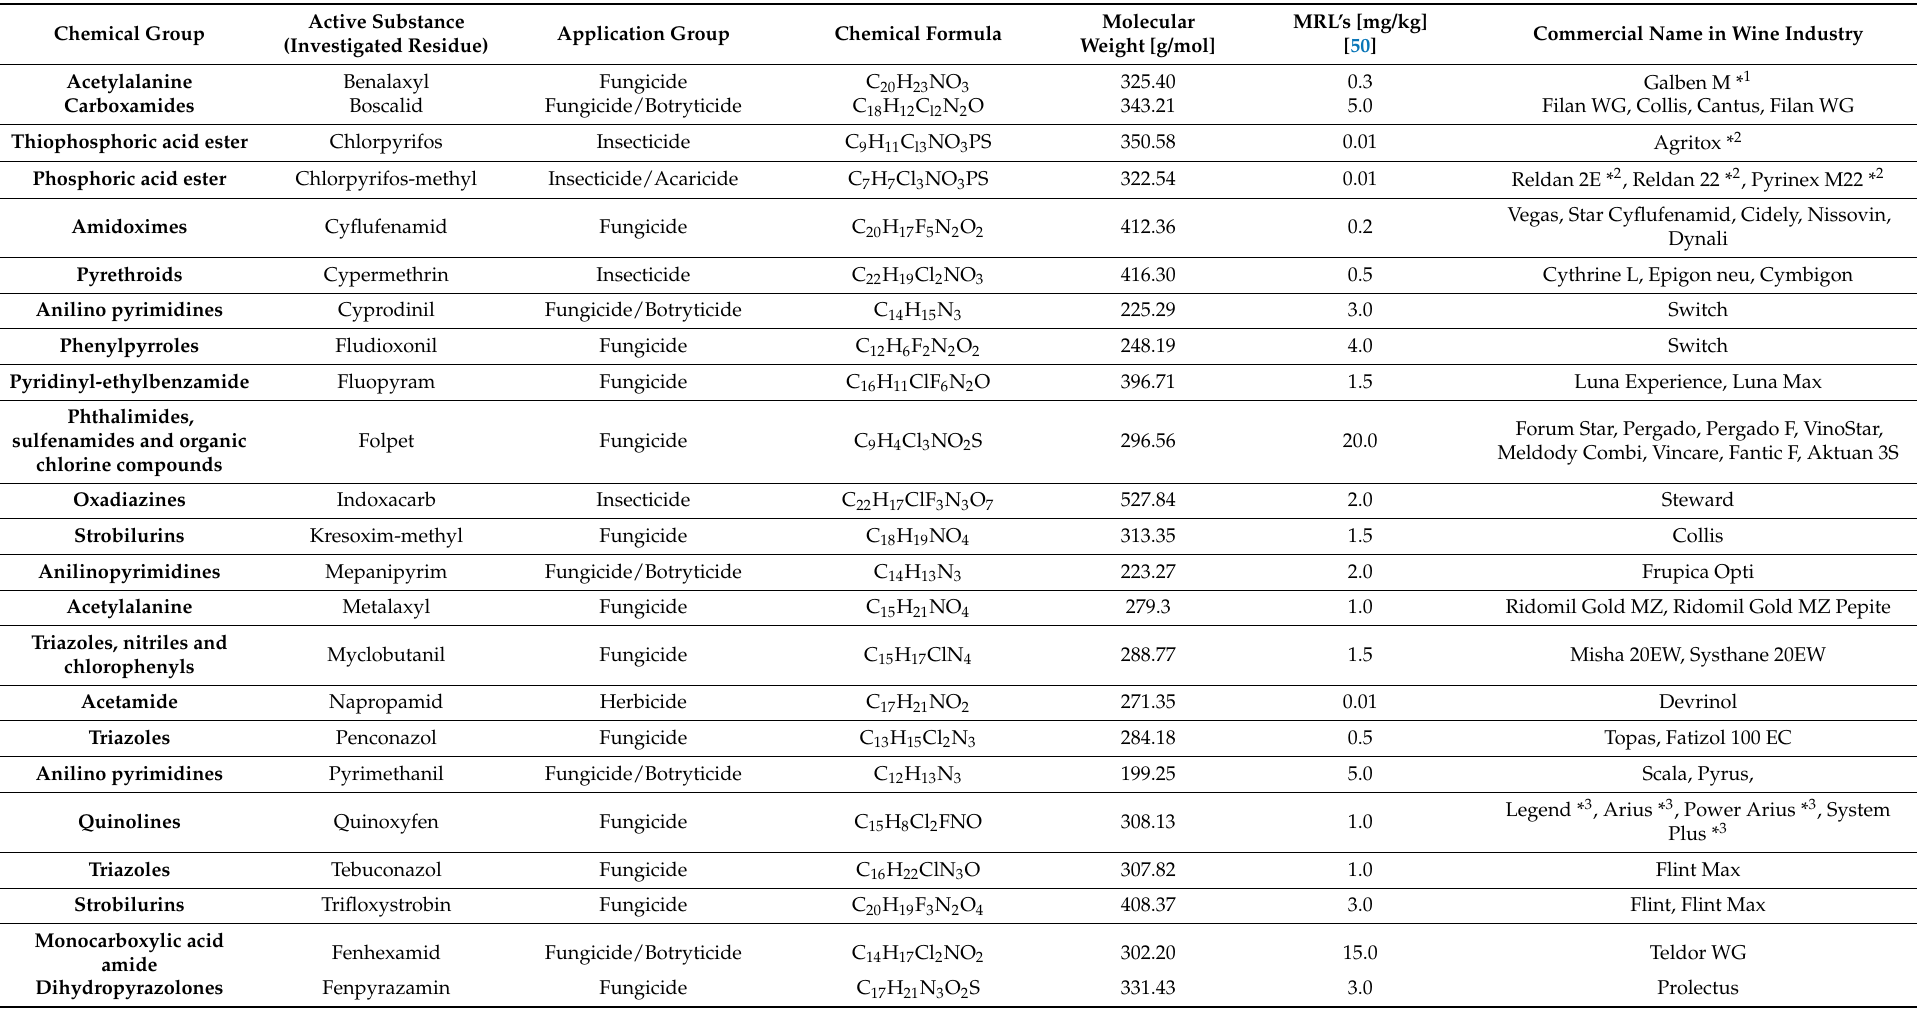
Table 1. Pesticide residues examined: chemical formula, molecular weight, Maxiumum Residues Limits (MRL’s) for wine grapes, commercial